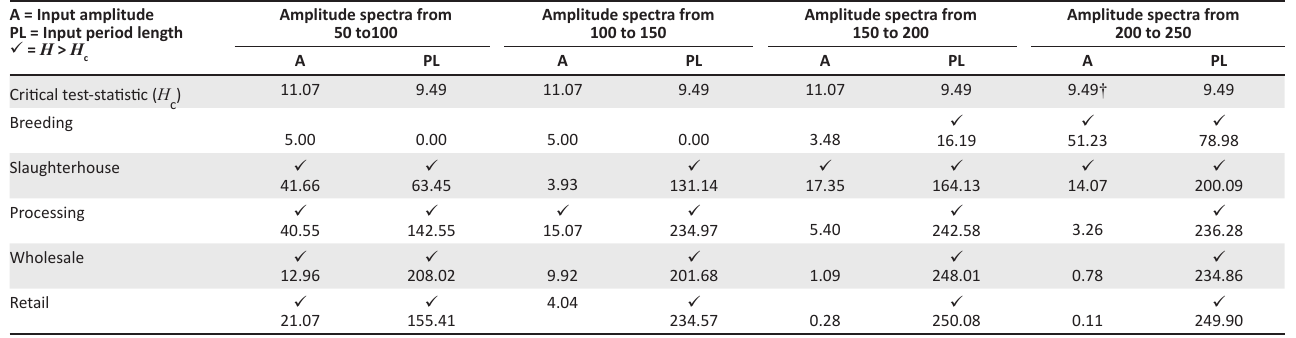
TABLE 6: Results of the Kruskal–Wallis